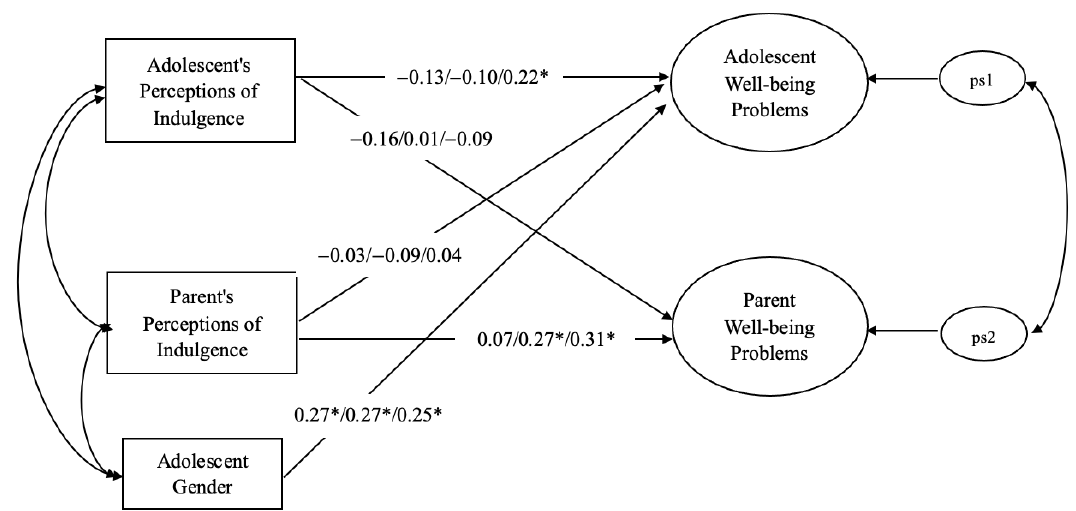
Figure 1. APIM: Indulgence and well-being problems. β = material/relational/behavioral indulgence. Adolescent gender was included as a covariate (1 = male 2 = female). * p < 0.05.